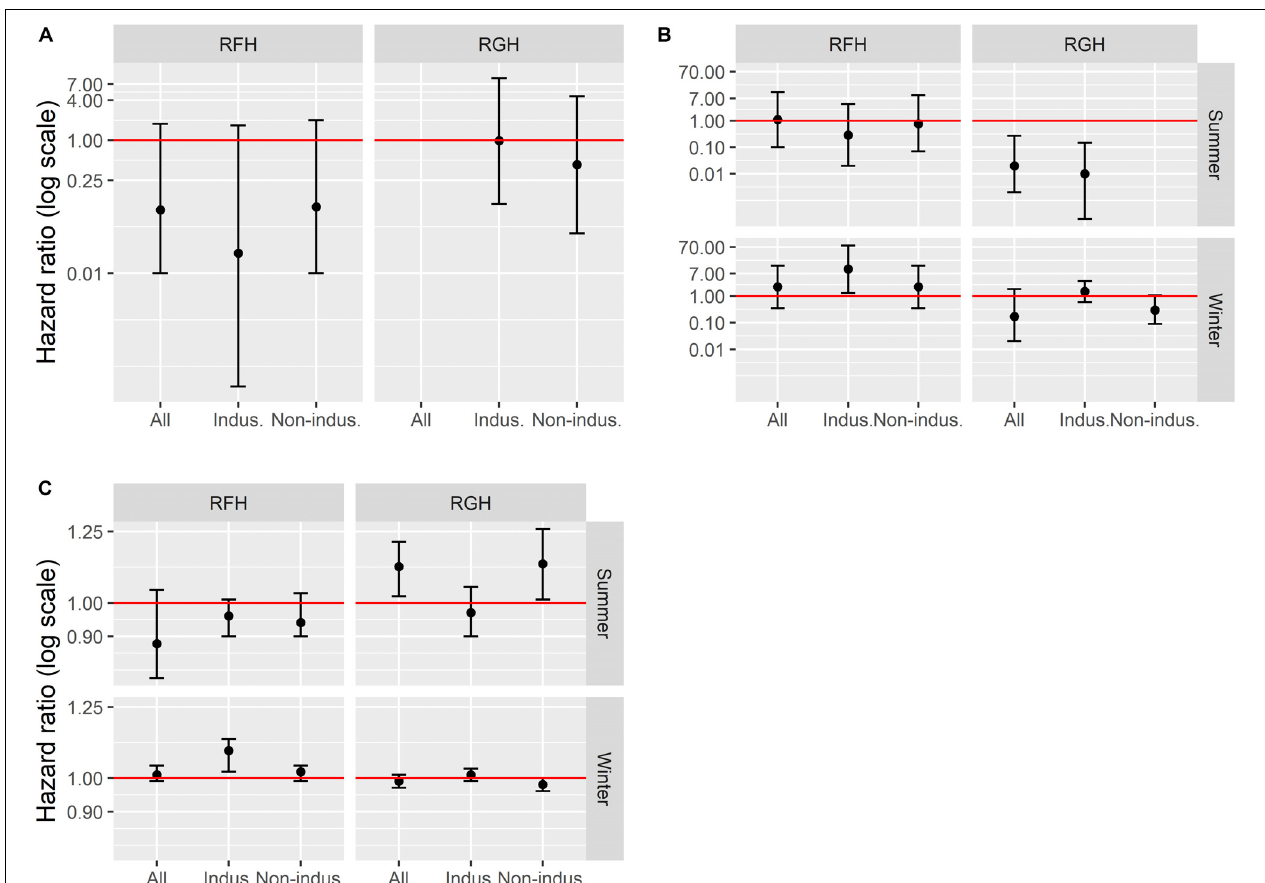
FIGURE 3 | Human disturbance effects [hazard ratio (HR), represented on a log scale] on caribou mortality risk at three temporal scales, early-life 1–7 years old; (A) , seasonal (B) and daily (C) mortality risk, and 95% confidence intervals, on the Rivière-aux-Feuilles (RFH) and Rivière-George herd (RGH), northern Québec, Canada, 2009–2016. A hazard ratio < 1 indicates that exposure to disturbances decreased mortality risk, whereas a hazard ratio > 1 indicates that exposure to disturbances increased mortality risk (red line = hazard ratio of 1). Disturbances tested included all disturbance types (mines, mining exploration, roads, and human settlements), industrial disturbances only (indus.; mine and mining exploration) and non-industrial disturbances only (non-indus.; roads and human